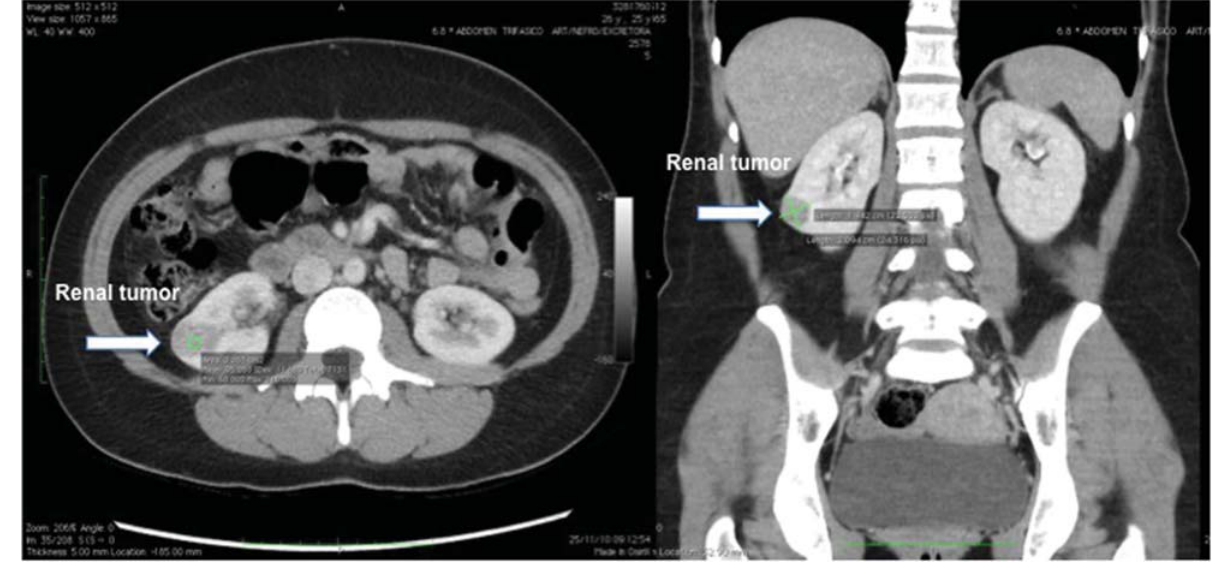
Figure 1 - Contrast-enhanced computed tomography reveals a 2.8 cm, well circumscribed, solid, hypoenhancing cortical lower pole mass in the right kidney with 100 Hounsfield Units (axial and coronal